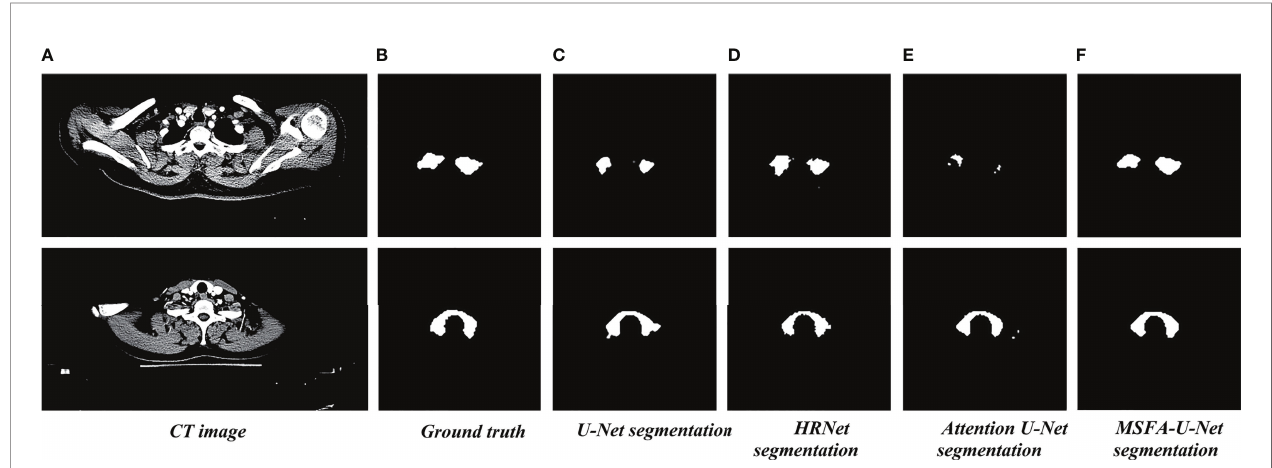
FIGURE 4 | Thyroid gland segmentation of the four models on localized CT images for radiotherapy. (A) Standard image of the imported model (CT image). (B) Corresponding label image (Ground truth). (C) Thyroid segmented by U-Net. (D) Thyroid segmented by HRNet. (E) Thyroid segmented by Attention U-Net. (F) Thyroid segmented by